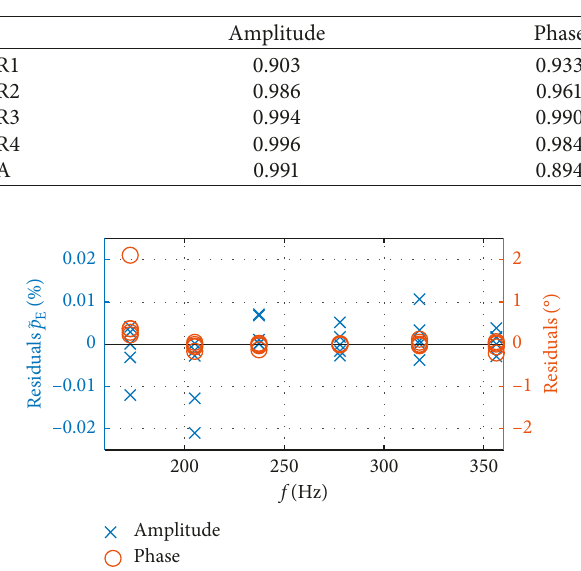
Figure 11: Residuals for the calculated model with two degrees of freedom in the acoustic pressure.